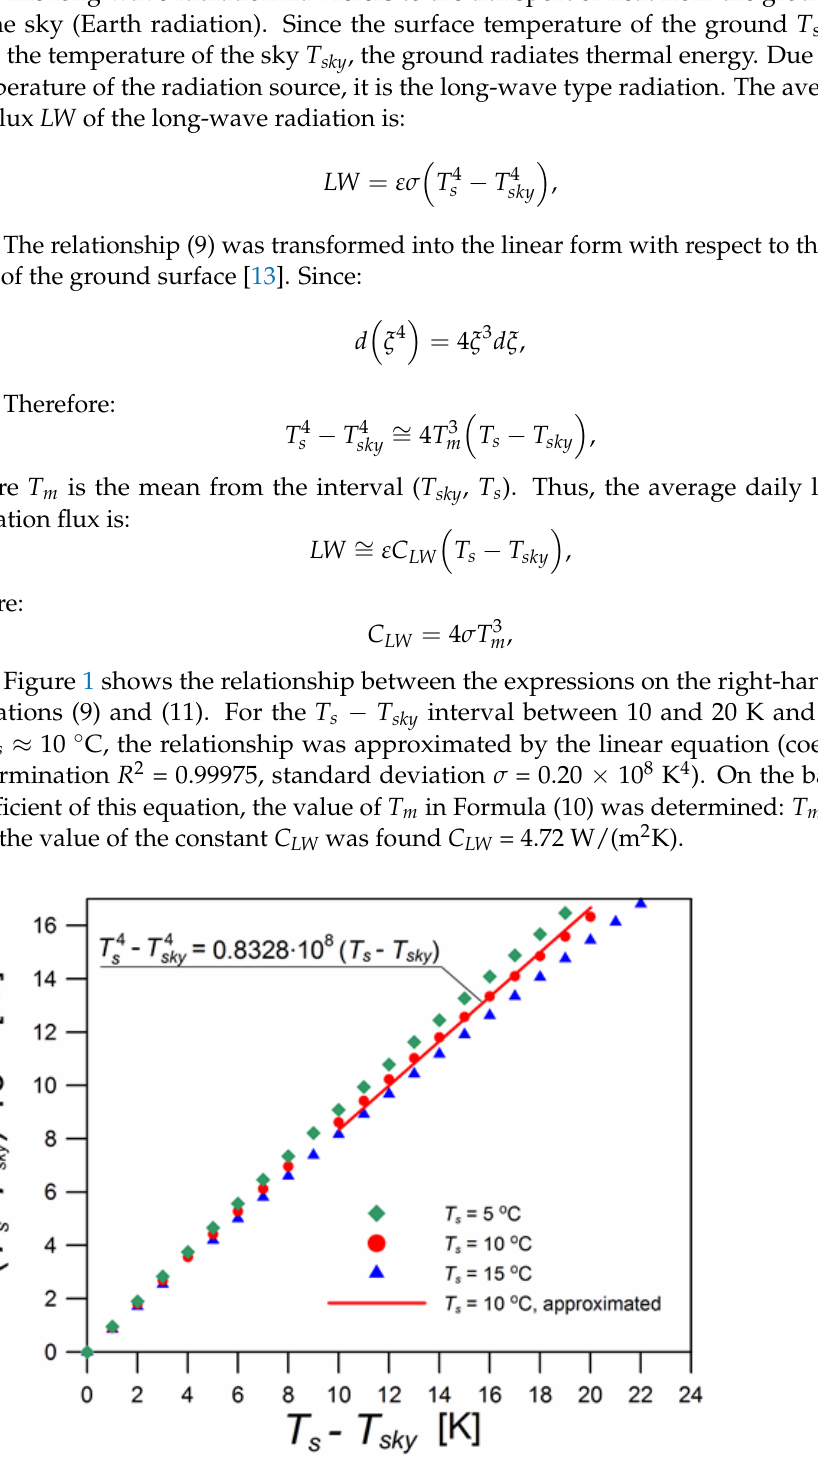
Figure 1. Linearization of Equation (9).